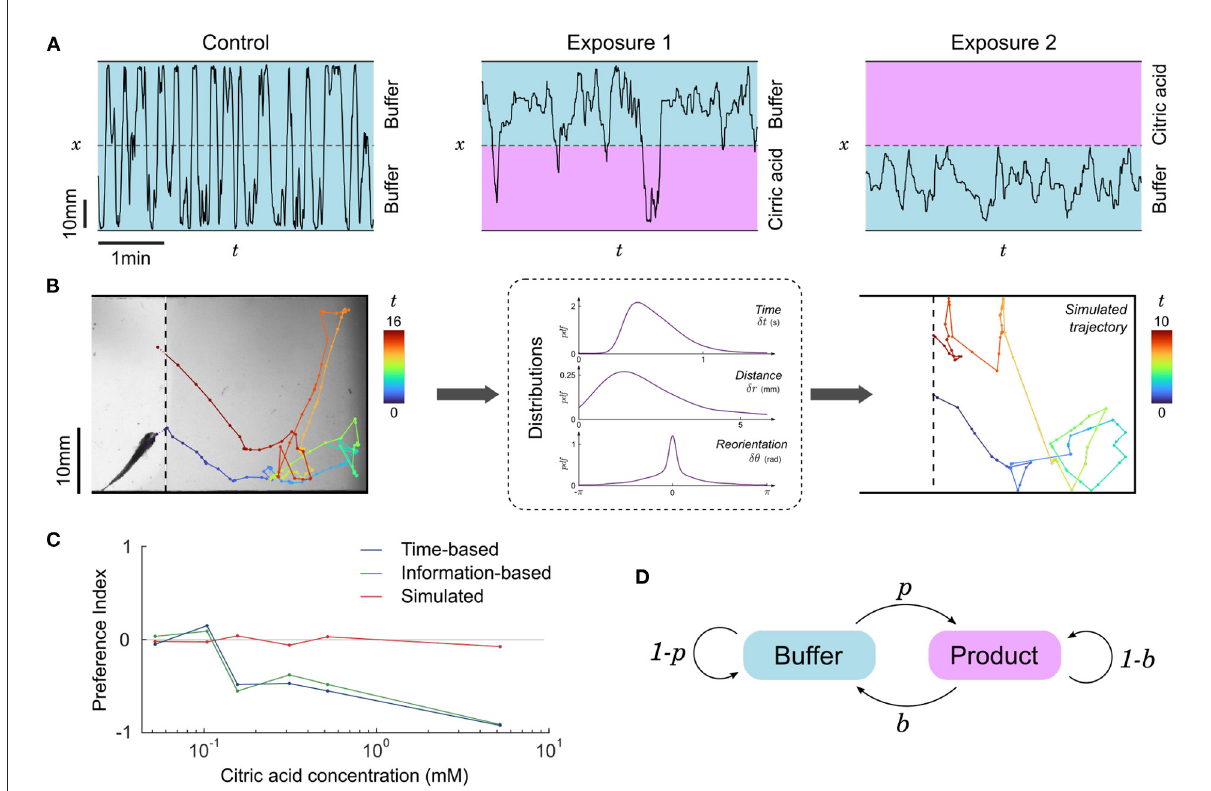
FIGURE4 Repulsion for citric acid. (A) Blow-ups of lateral traces ( x -position vs. time) of the same 31 dpf zebrafish during control and two successive exposures to citric acid (476 µ M ) on alternating sides. (B) Left: Sample piece of trajectory between two contacts with the interface, same fish. Color code: time (seconds). Middle: distributions of time, distance traveled and change of orientation between successive bouts from all pieces of trajectories of all fish in the same condition (product side at 476 µ M ). Right: Example of a simulated trajectory based on these distributions. (C) Preference index as a function of citric acid concentration. The experimental time-based and information-based preference indices indicate a clear repulsion above a threshold close to 100 µ M , while the time-based preference index of simulated data remains neutral. Successive exposures are pooled together, n =15, 9, 6, 6, 10, and 3 fish for increasing concentrations. (D) Two-state Markov model of transitions: animals cross the boundary from buffer to product with probability p and from product to buffer with probability b